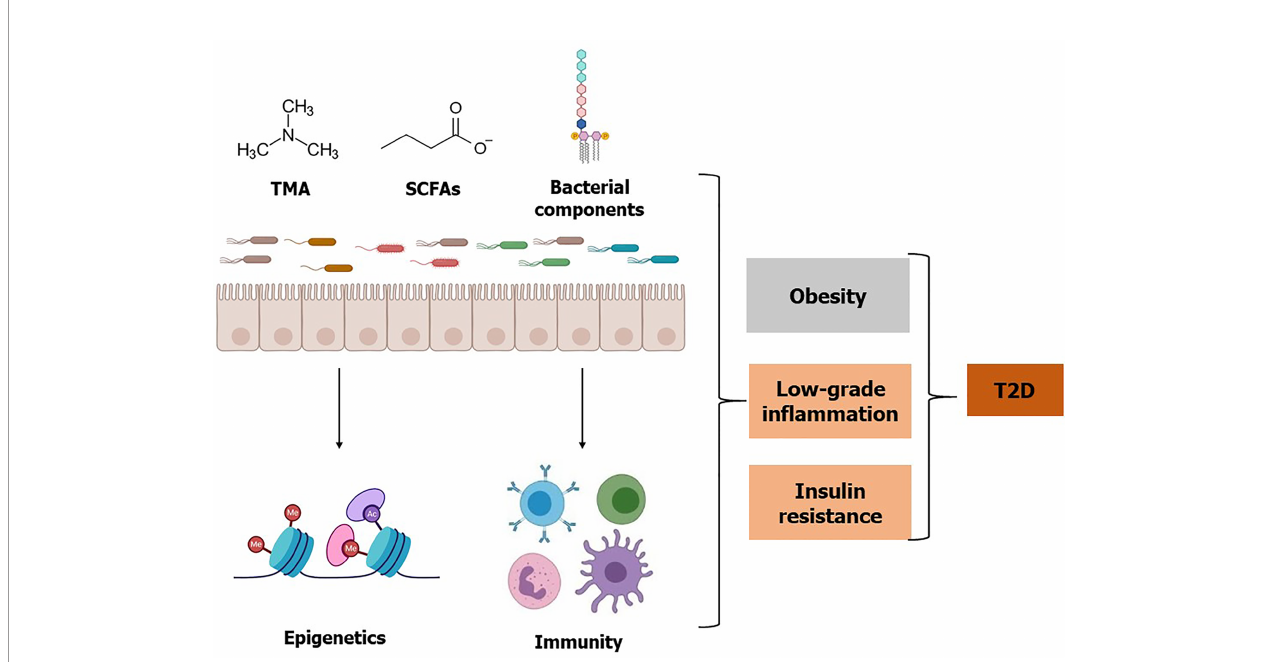
FIGURE 2 | Effects of gut microbiota, microbial metabolites, and bacterial components on T2D . Gut microbiota and speci fi c bacterial taxa are associated with a risk of obesity, low-grade in fl ammation, and insulin resistance. Microbial metabolite TMA is converted to TMAO by the host enzyme and elevated TMAO is associated with insulin resistance. Whereas some bacterial metabolites such as SCFAs may improve glucose homeostasis. Additionally, SCFAs in fl uence epigenetic programming by inhibiting histone deacetylase enzyme activity, which may improve insulin resistance and T2D. Besides live bacteria, bacterial components such as LPS, fl agellin, and peptidoglycan can elicit an in fl ammatory response and may contribute to the increased risk of T2D. Conversely, some bacterial components such as Amuc 1100 can improve T2D. Referred studies can be found on the main body of this